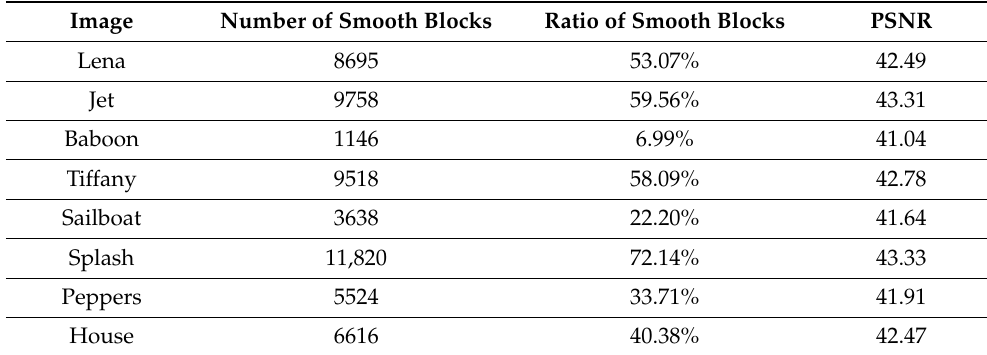
Table 2. The relation between the ratio of smooth blocks and the PSNR of images.